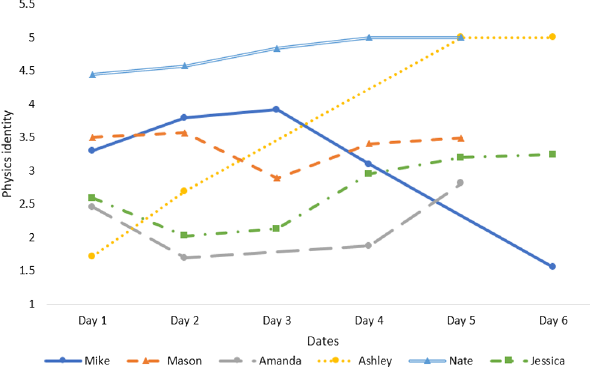
FIG. 3. Physics identity traces of the six